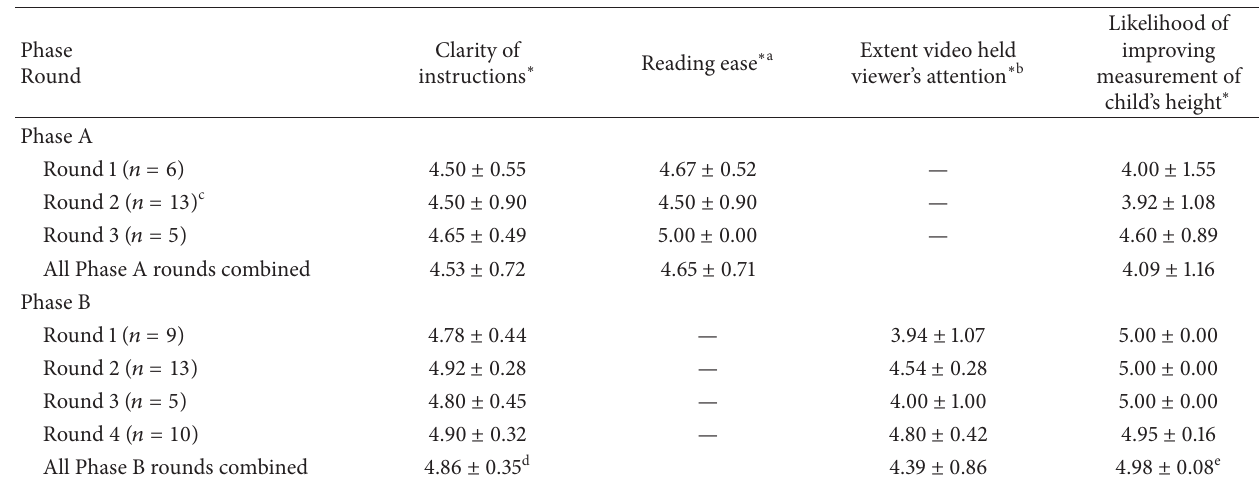
Table 2: Parent rating of height